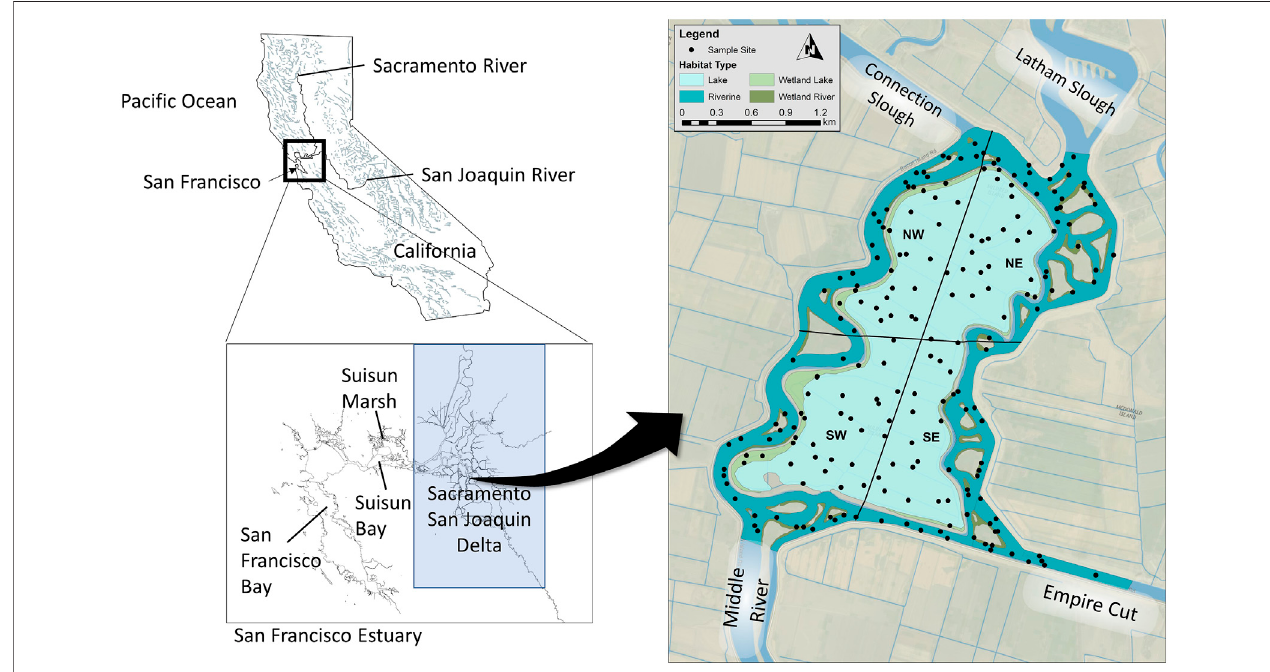
FIGURE 1 | Sampling locations within Mildred Island in relationship to the Sacramento-San Joaquin Delta, and San Francisco Estuary of California.